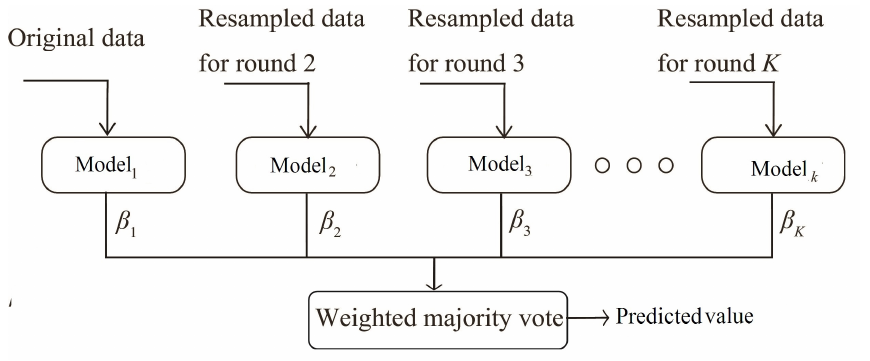
Figure 2. Accumulation of weak models through the boosting technique